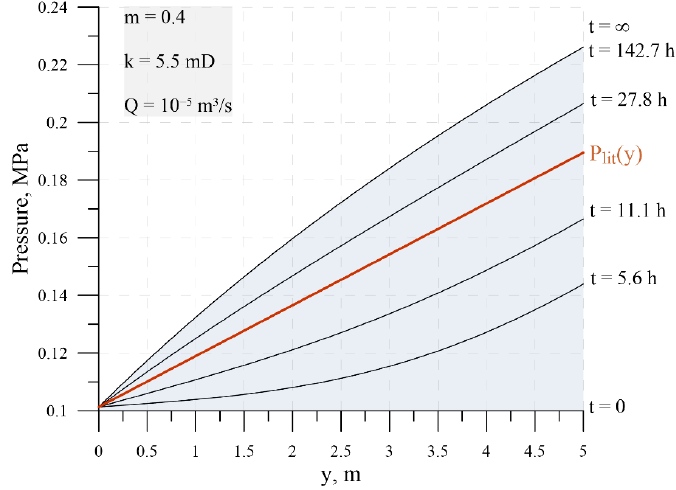
Figure 2. Depth-dependent pressure variations at 5.6 h, 11.1 h, 27.8 h, and 142.7 h after t 0 . As the gas pressure reaches the critical value (black heavy line in Figure 3), blowout may occur both on the upper (Figure 3a) and lower (Figure 3b) boundaries of the modeling domain, which differ in permeability by less than one order of magnitude.